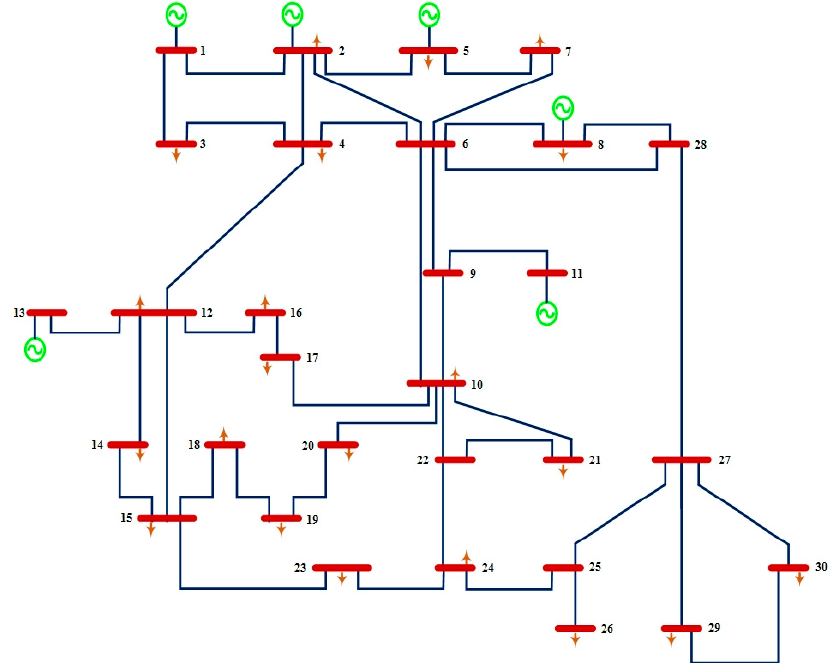
Figure 2. Standard IEEE 30 bus test system.